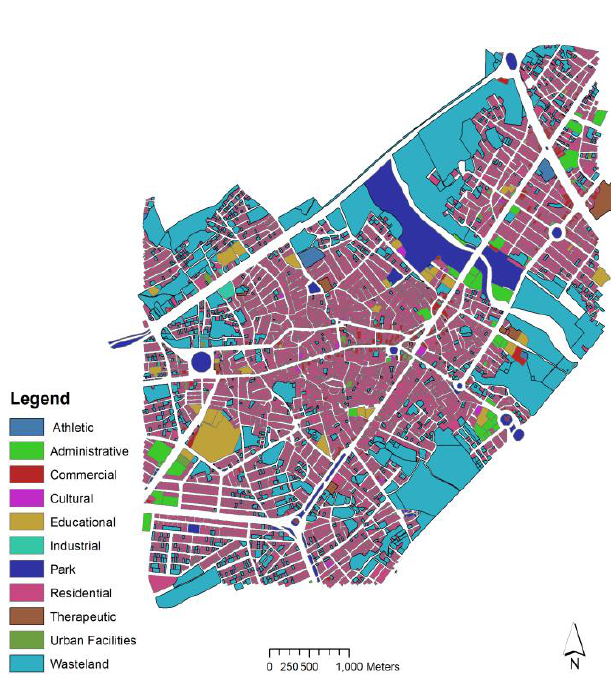
Figure 1. Abhar city map. Different applications show with different colours